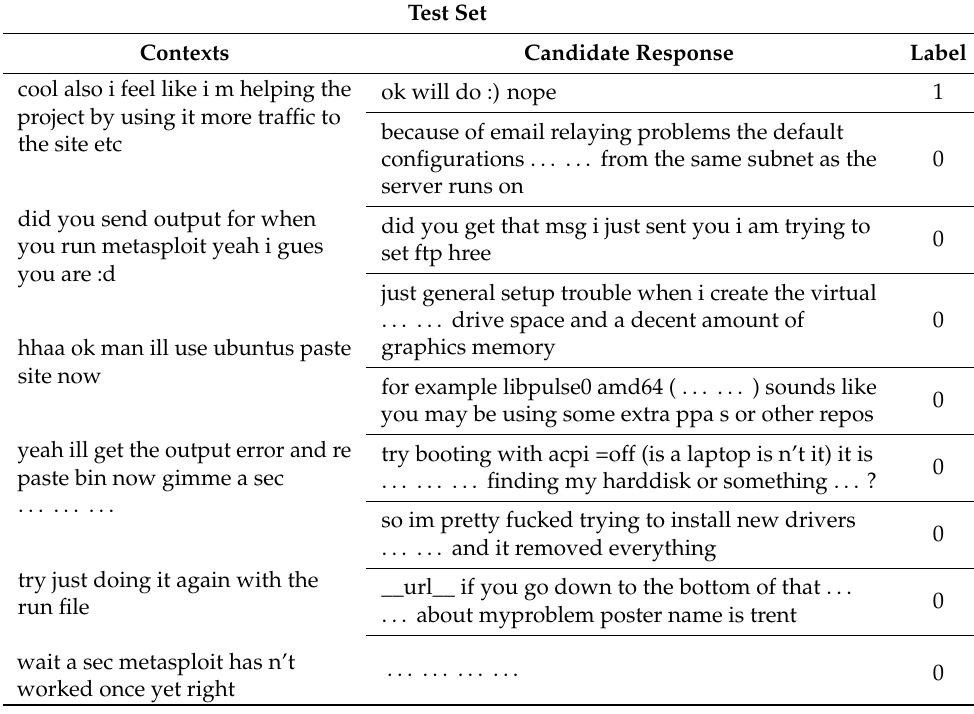
Table 2. Ubuntu Data Set (Test Set).